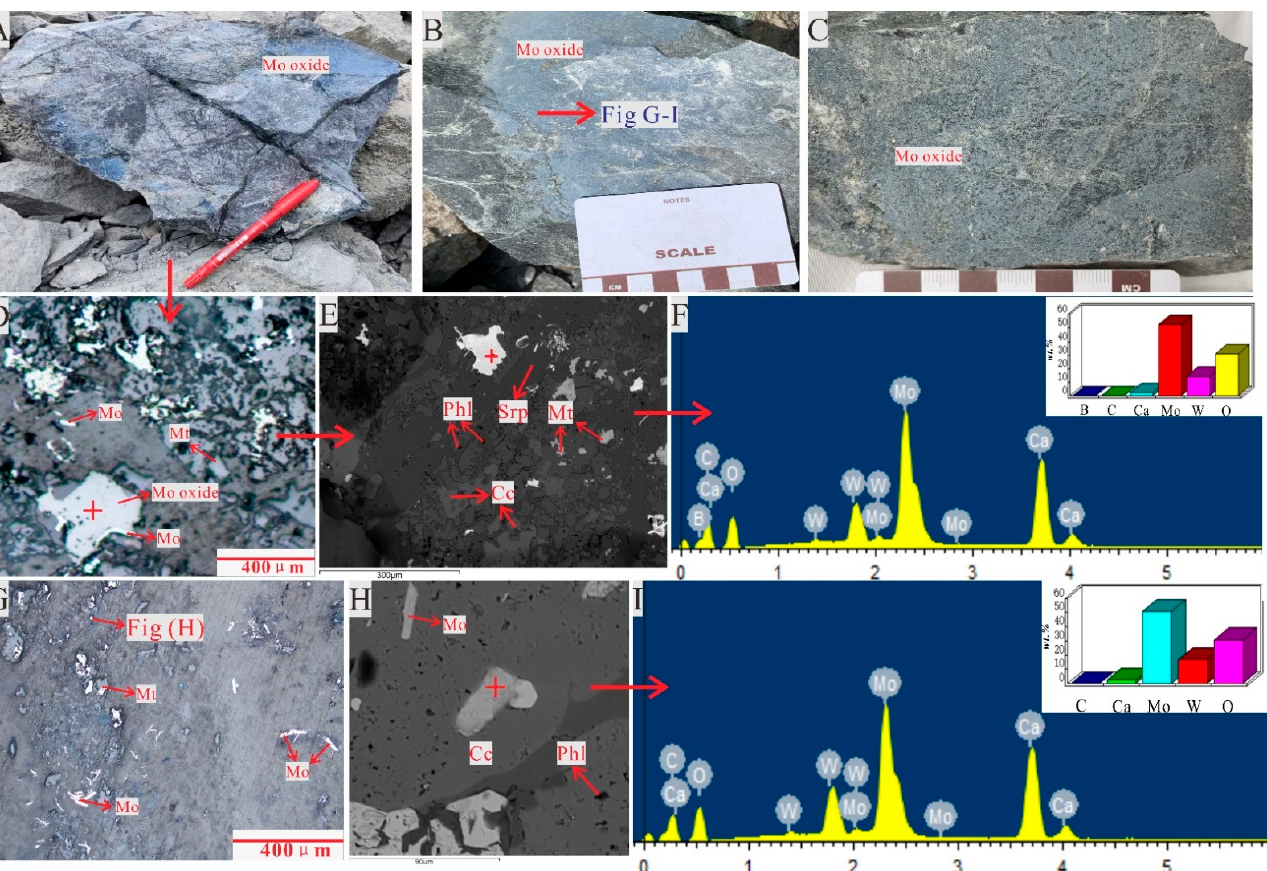
Figure 11. Photographs showing the characteristics of field and hand specimens of Mo oxide ores as well as SEM analysis results: ( A – C ) Mo oxide ores; ( D , G ) molybdenite and associated with magnetite; ( E , H ) the test points of EDS and BSE of the Mo oxide minerals and accompanying gangue minerals; ( F , I ) results of EDS. Abbreviations: Mo, molybdenite; Mt, magnetite; Cc, calcite; Phl, phlogopite; Srp, serpentine.